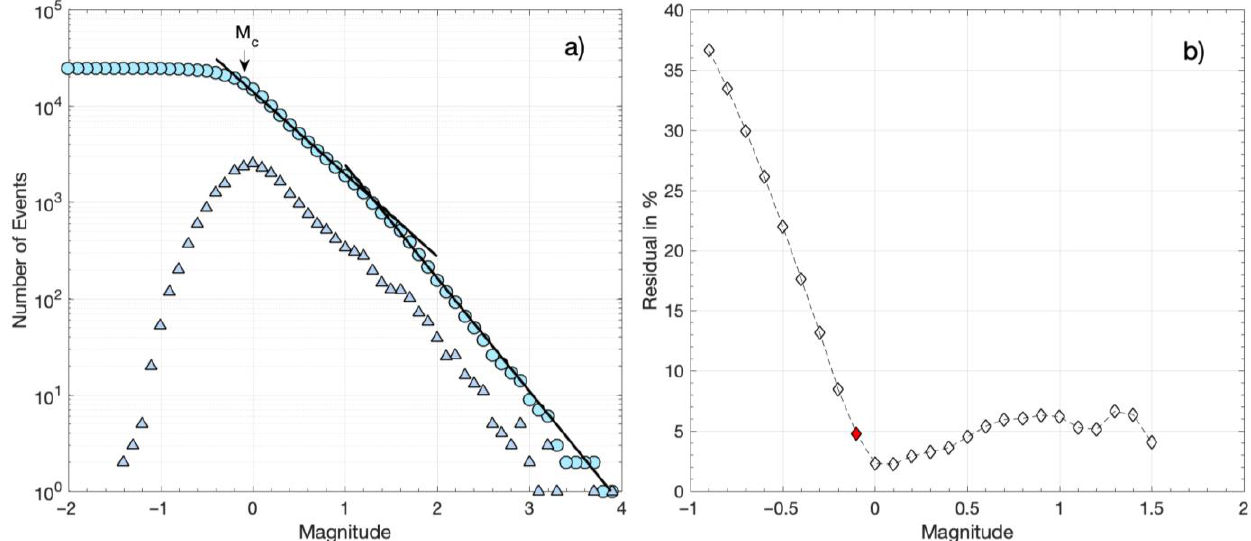
Figure 6. ( a ) Cumulative (filled circles) and discrete (filled triangles) frequency – magnitude distribution for CAT2. The two solid lines represent the G – R relation for the parameter values of a = 4.15 and b = 0.86 for a cut-off magnitude −0 .1, and a = 4.57, and b = 1.18 for a cut-off magnitude of 1.5. ( b ) Residual plot between the observed frequency – magnitude distribution and the fit to the G – R relation as a function of the lower-magnitude cut-off. The filled red symbol represents the M c of −0 .1 for 95% residuals.